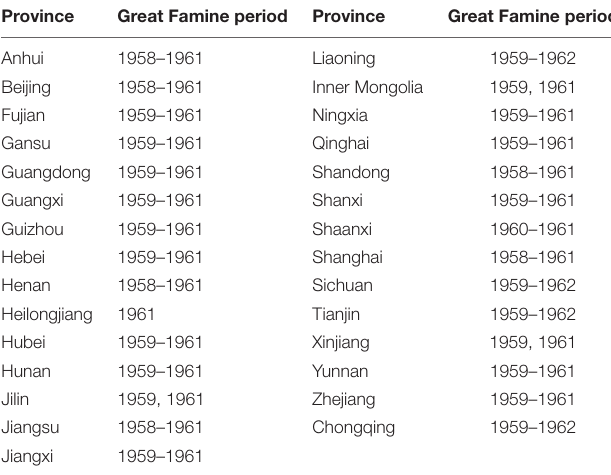
TABLE 3 | Great Famine period across